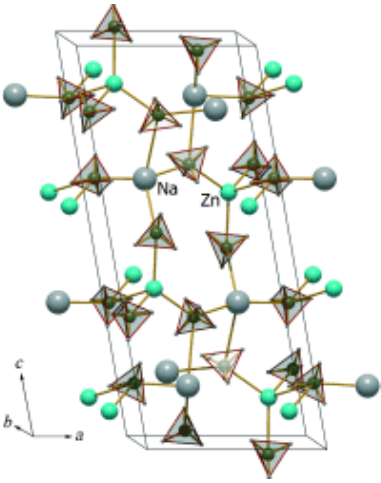
Figure 10. Crystal structure of NaZn(BH 4 ) 3 ; Zn atoms in blue, B in brown, Na in dark grey, and H in light grey [77]. Reprinted with permission from [77], copyright 2009 John Wiley & Sons.